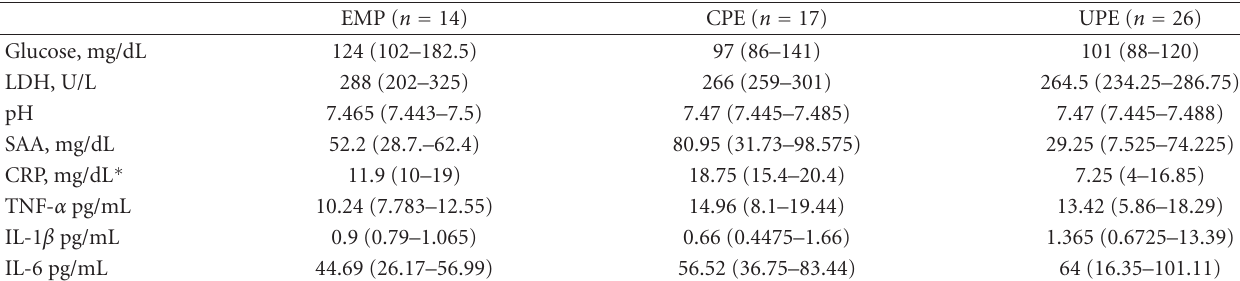
Table 3: Serum levels of biochemical parameters and of di ff erent cytokines in PPE.